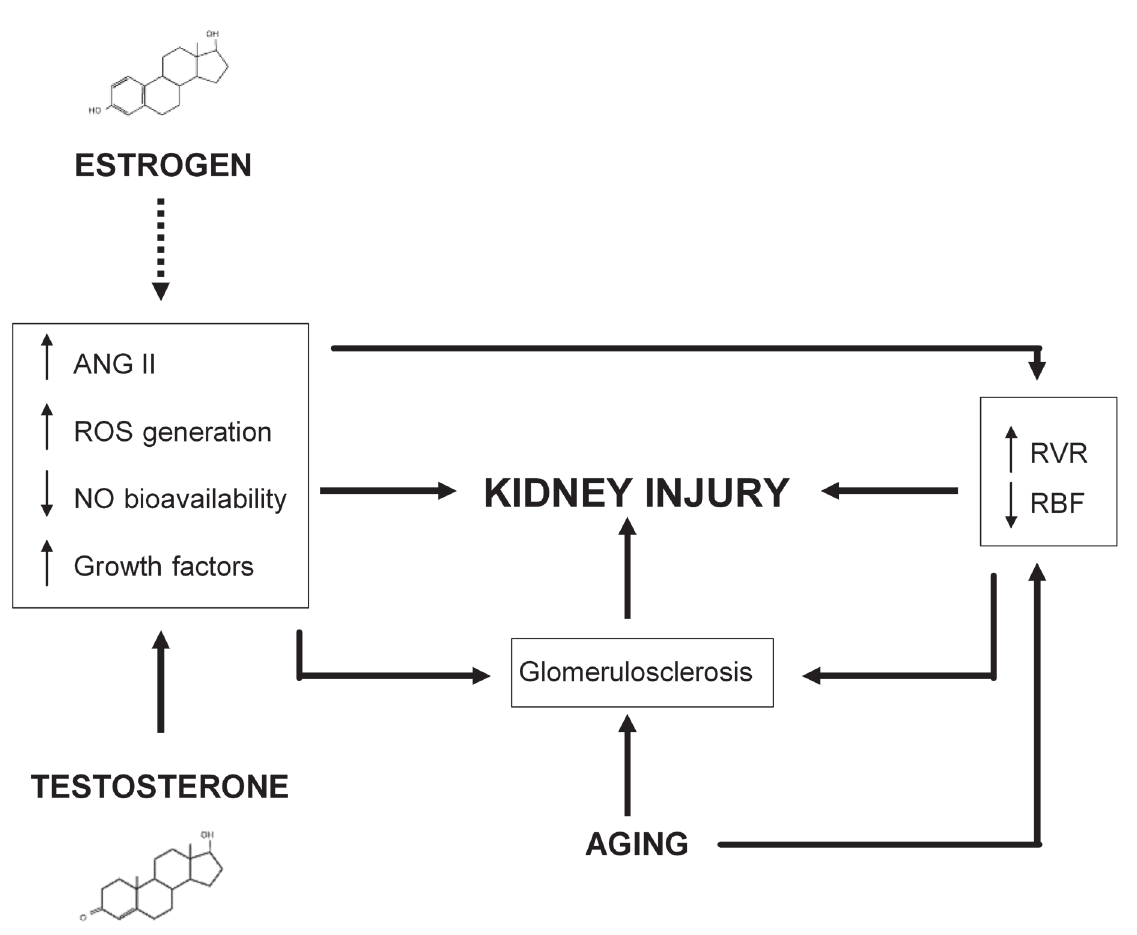
Figure 2. The role of estrogen, testosterone and aging in kidney damage. ANG II = angiotensin II; ROS = reactive oxygen species; NO = nitric oxide; RVR = renal vascular resistance; RBF = renal blood flow. The dashed arrow and the continuous arrows indicate an inhibitory and a stimulatory effect,